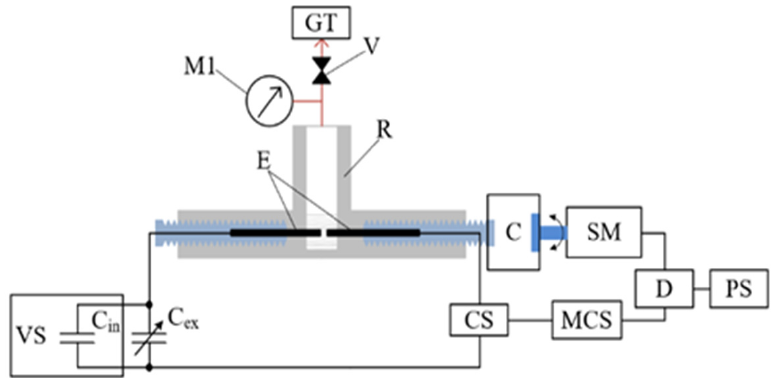
Figure 1. Scheme of the experimental setup: R—reactor; RC—reflux condenser; E—electrodes;